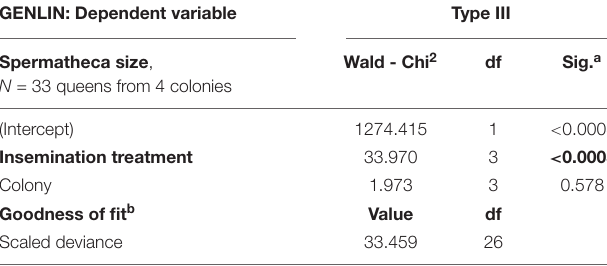
TABLE 3A | Spermathecal sizes (diameters) of Atta colombica queens that had survived one of the insemination treatment, i.e., full ejaculates ( N = 7), sperm only ( N = 5), seminal fluid only ( N = 10) or Hayes saline solution ( N = 11) varied widely between treatments ( Figure 4A ), but we found no difference in spermatheca sizes across the four colonies from which queens were sampled.